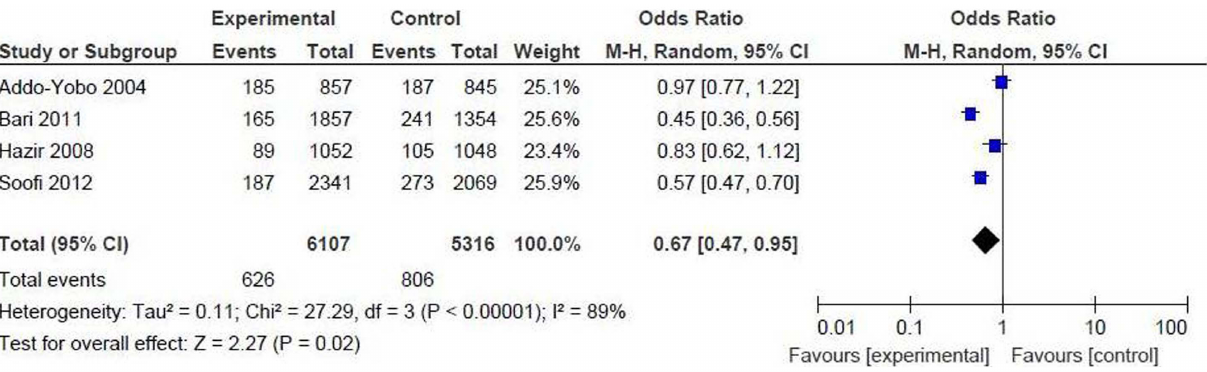
Figure 4. Primary outcome measures [oral amoxicillin versus others]. Proportion of children developing treatment failure at day 6.